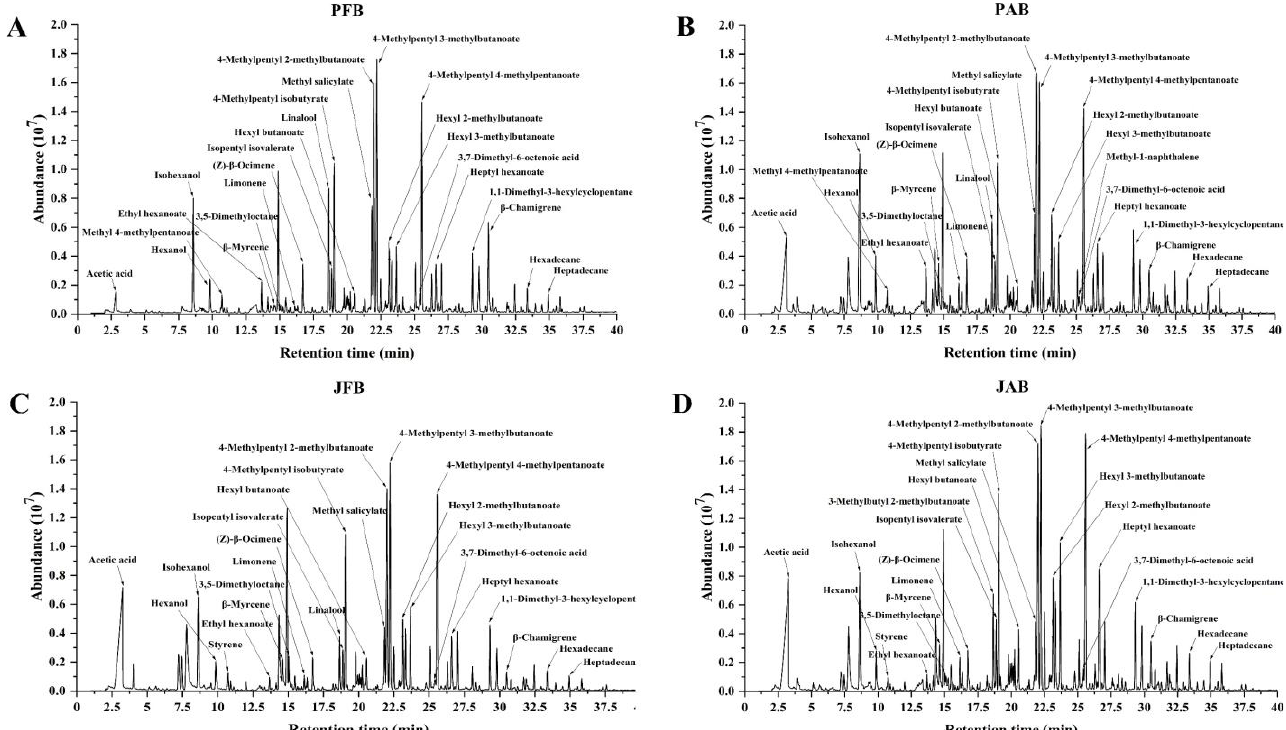
Figure 4. Representative total ion chromatograms of the headspace volatile compounds pickled chili pepper processed by PFB ( A ), PAB ( B ), JFB ( C ), and JAB ( D ) fermented for 30 days. The most abundant peaks were identified and marked on the chromatograms.